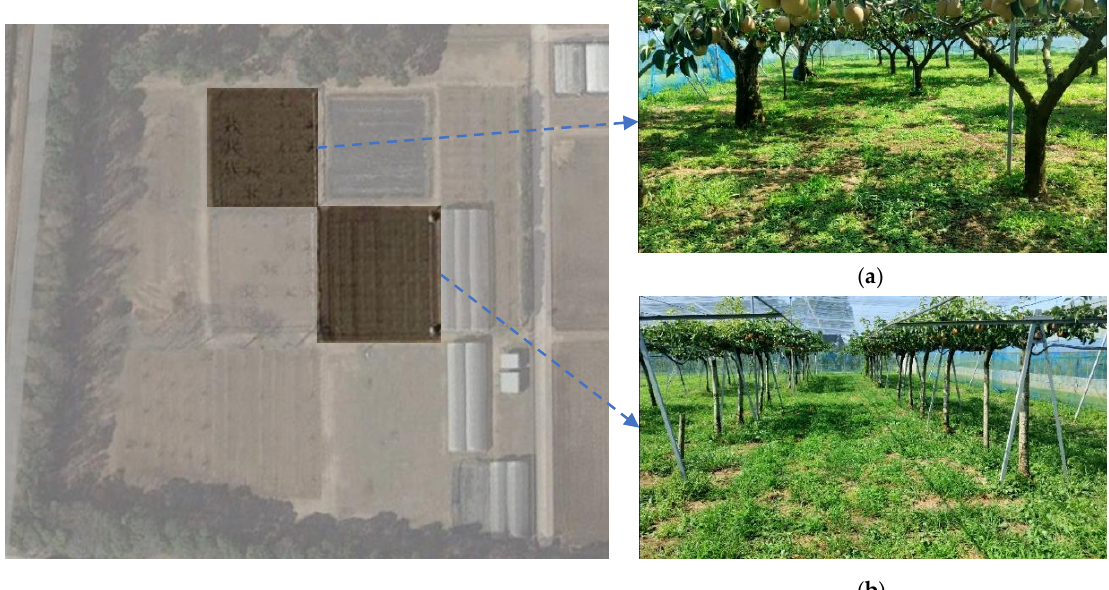
Table 1. Dataset collection times and light conditions in orchards.